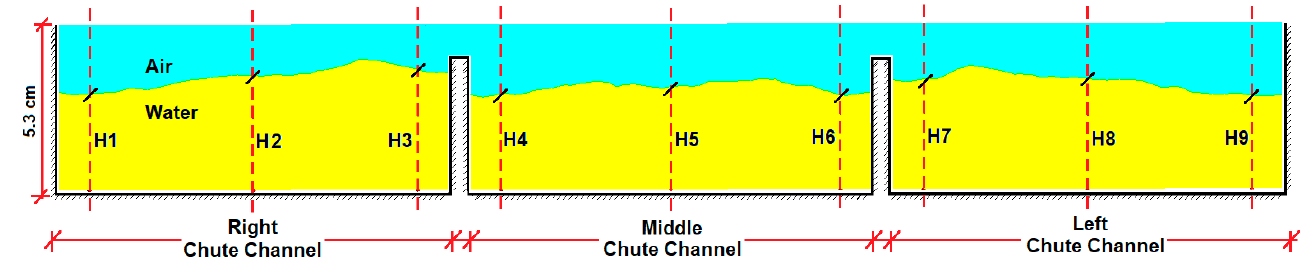
Figure 21. CFD water depth contours for Cross-section 1.